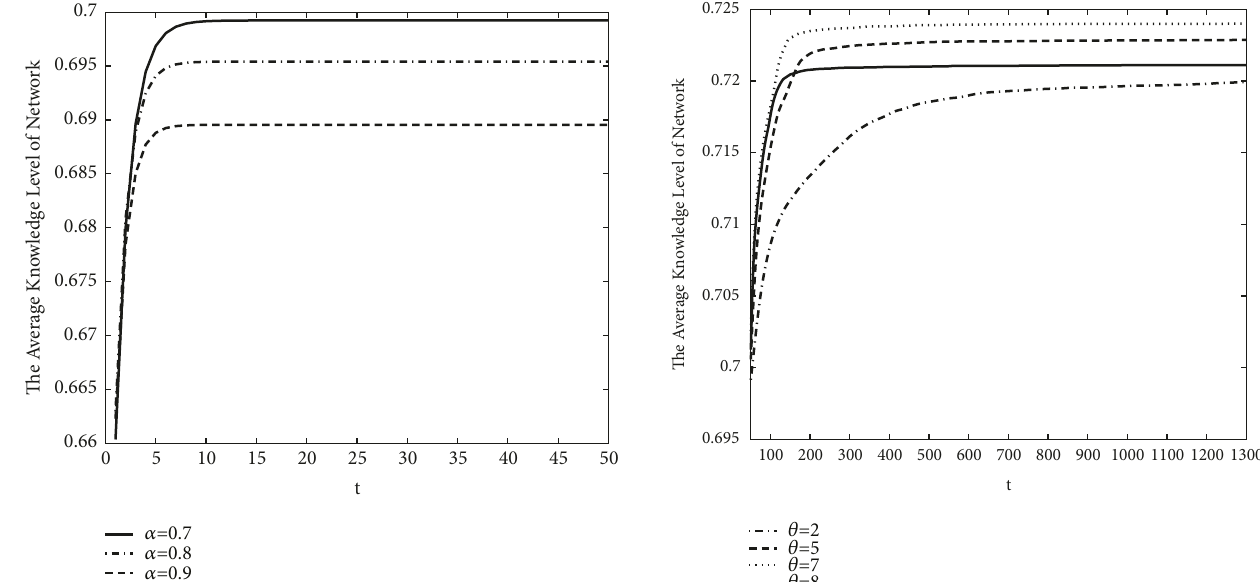
Figure 3: When 𝛼 = 0.7 network average knowledge level evolution diagram under different 𝜃